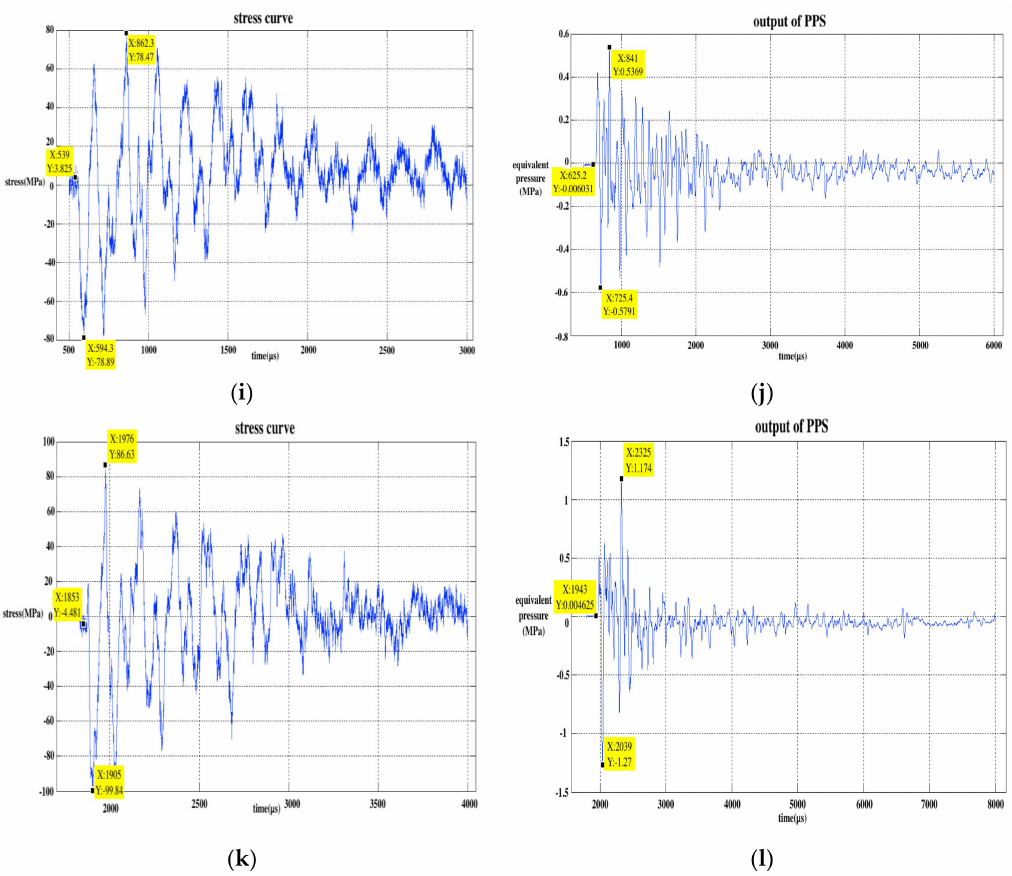
Figure 3. Experimental data of the stress wave e ff ect SWE: ( a ) stress at 30 degrees; ( b ) output of PPS at 30 degrees; ( c ) stress at 60 degrees; ( d ) output of PPS at 60 degrees; ( e ) stress at 90 degrees; ( f ) output of PPS at 90 degrees; ( g ) stress at 120 degrees; ( h ) output of PPS at 120 degrees; ( i ) stress at 150 degrees; ( j ) output of PPS at 150 degrees; ( k ) stress at 180 degrees; ( l ) output of PPS at 180 degrees. With the increase in the releasing angle of the hit bar, the maximum peak value of the stress wave signal increased and the peak value of the PPS output signal also increased correspondingly. The stress wave signal and PPS output signal were both positive and negative. The curve presented damped oscillations related to the reflection to the bars’ end. In addition, the output signal of the PPS had some degree of drift, and its baseline moved down significantly at 120 degrees. The data from one SWE experiment are listed in Table 1. In Table 1, the highest positive peaks and highest negative peaks represent the maximum positive and negative absolute values on the stress wave and PPS output curves; the spectrum points represent the frequency points corresponding to the first two maximum values on the spectrum curves of the two type signals after fast Fourier transform (FFT); and the positive EP–stress ratio represents the ratio of the positive EP value to the positive stress wave value in the same column in the table and the same calculating method for the negative EP–stress ratio. According to the position of the strain gauges on the bars and the velocity of the stress wave in steel (5800 m / s), the frequency of stress wave signal can be calculated theoretically. The geometric position relationship between the strain gauges and the input and output bars is shown in Figure 4. When the stress wave passes through strain gauge 2 for the first time, it will propagate to the right end of the bar. The stress wave then passes through strain gauge 2 again after reflection and then propagates to the left. The stress wave continues to propagate back and forth in the bars, and its amplitude gradually